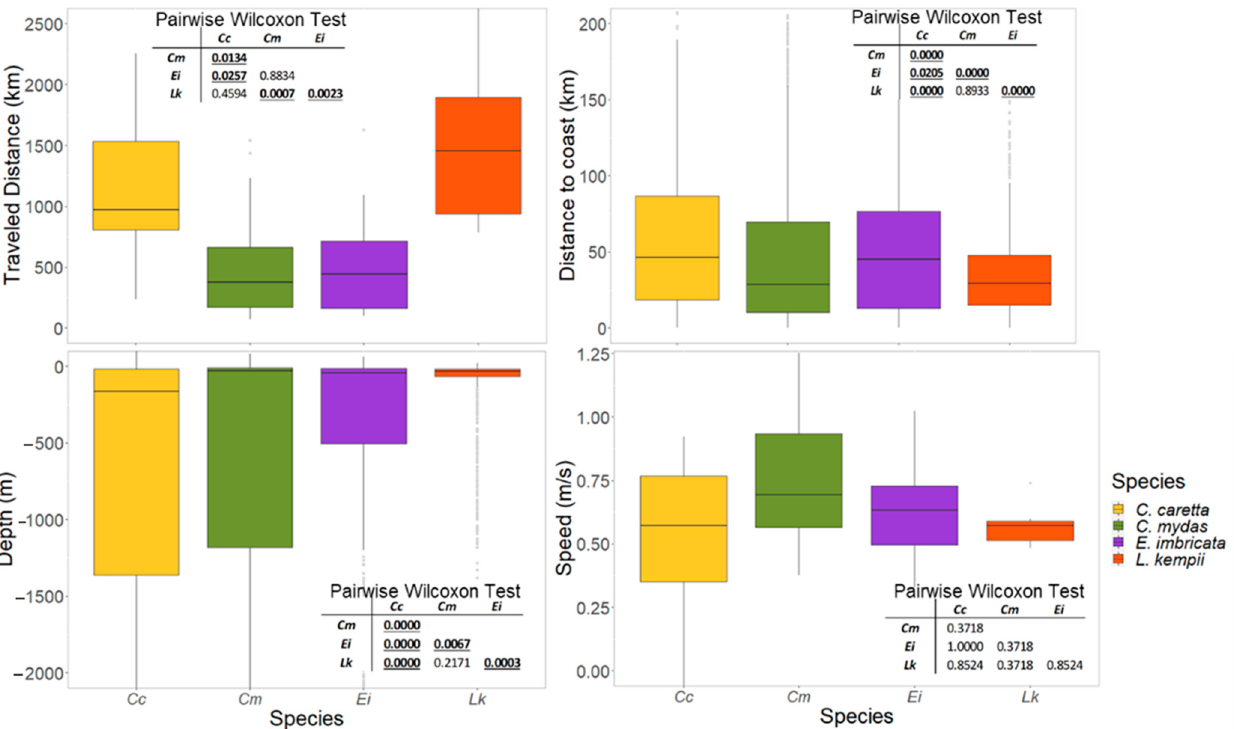
Figure 8. Descriptive statistics and hypothesis test for physical variables for migratory corridors of post-nesting sea turtles of the four distinct species satellite-tracked from their nesting beaches at the Gulf of Mexico and West Caribbean. A pairwise Wilcoxon Rank Sum hypothesis test is presented as inset table for comparisons between species.